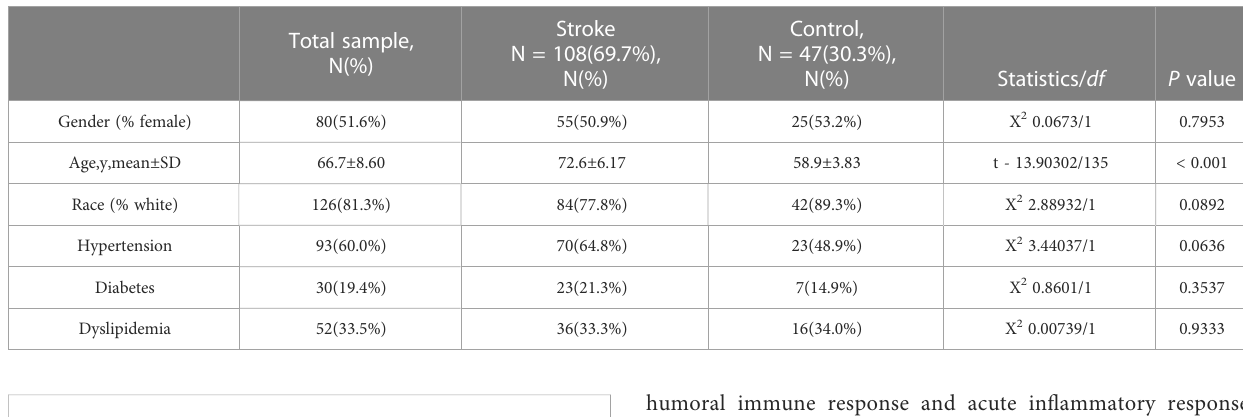
TABLE 3 Clinical characters of samples in the merged IS training data